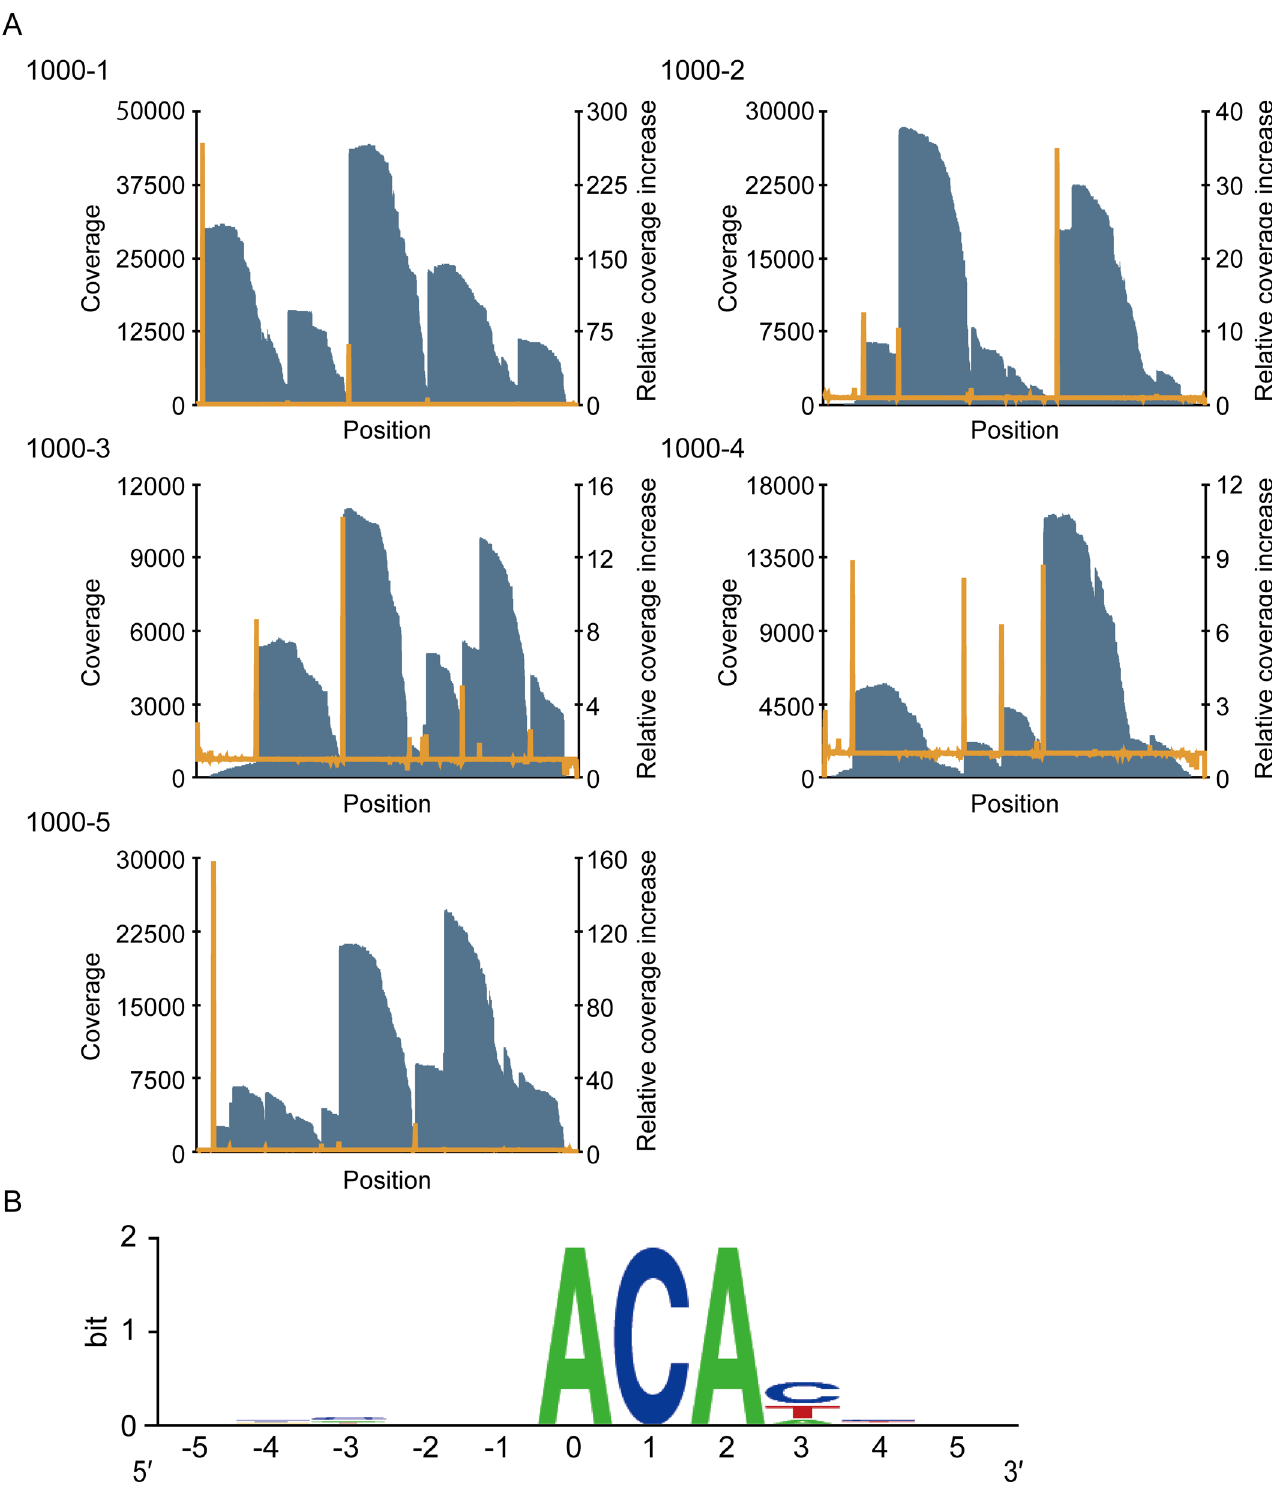
Fig 2. Identification of the MazF cleavage sequence using massive parallel sequencing. (A) Graph of the coverage (blue bar) and the relative coverage increase (orange line). (B) Graphical representation of the conserved sequences. The nucleotide position with significant increases in coverage was numbered as zero. Twenty-five sequences were analyzed (S2 Table) and the frequency at each position was visualized with the WebLogo program [37].